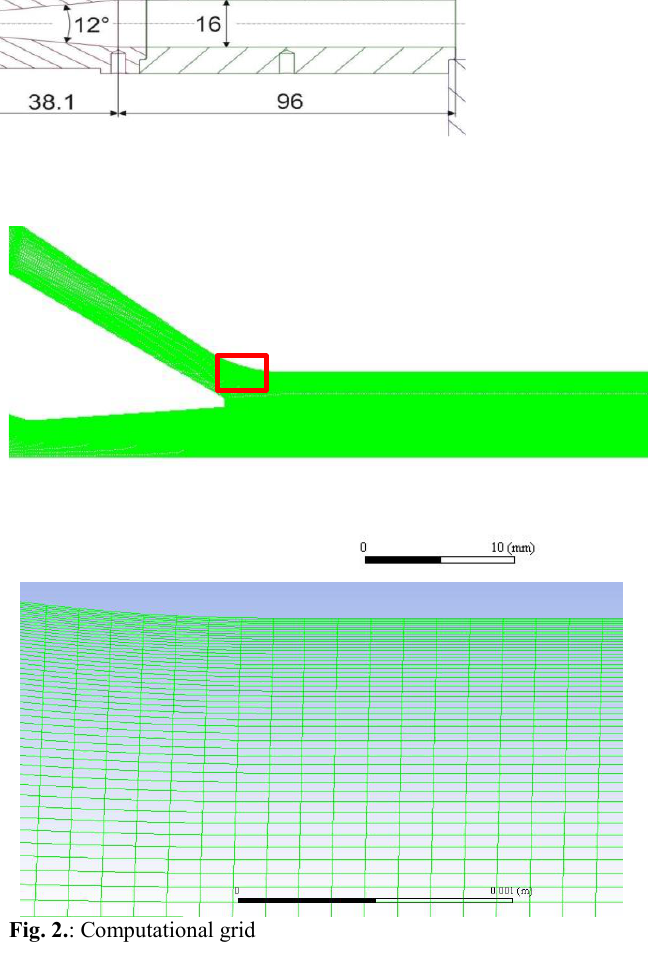
Fig. 2. : Computational